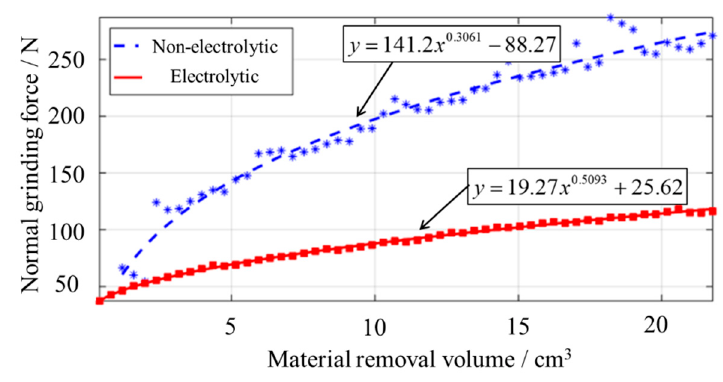
Figure 4. Evolution of grinding force during grinding of silicon carbide material.